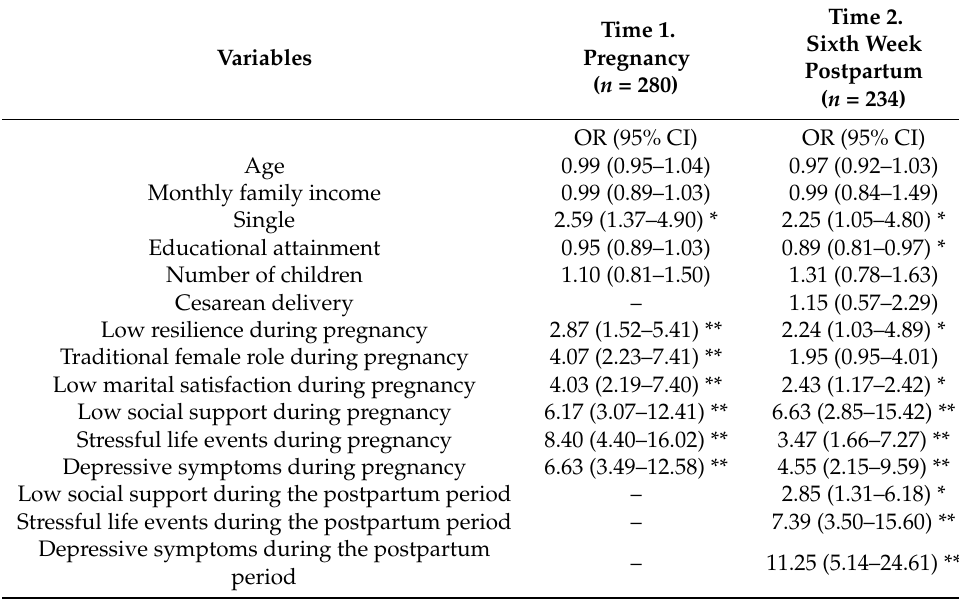
Table 3. Bivariate odds ratios (ORs) with 95% confidence intervals (CIs) for demographic, obstet- ric and psychosocial variables associated withanxiety symptoms in pregnancy and sixth postpar- tum week.